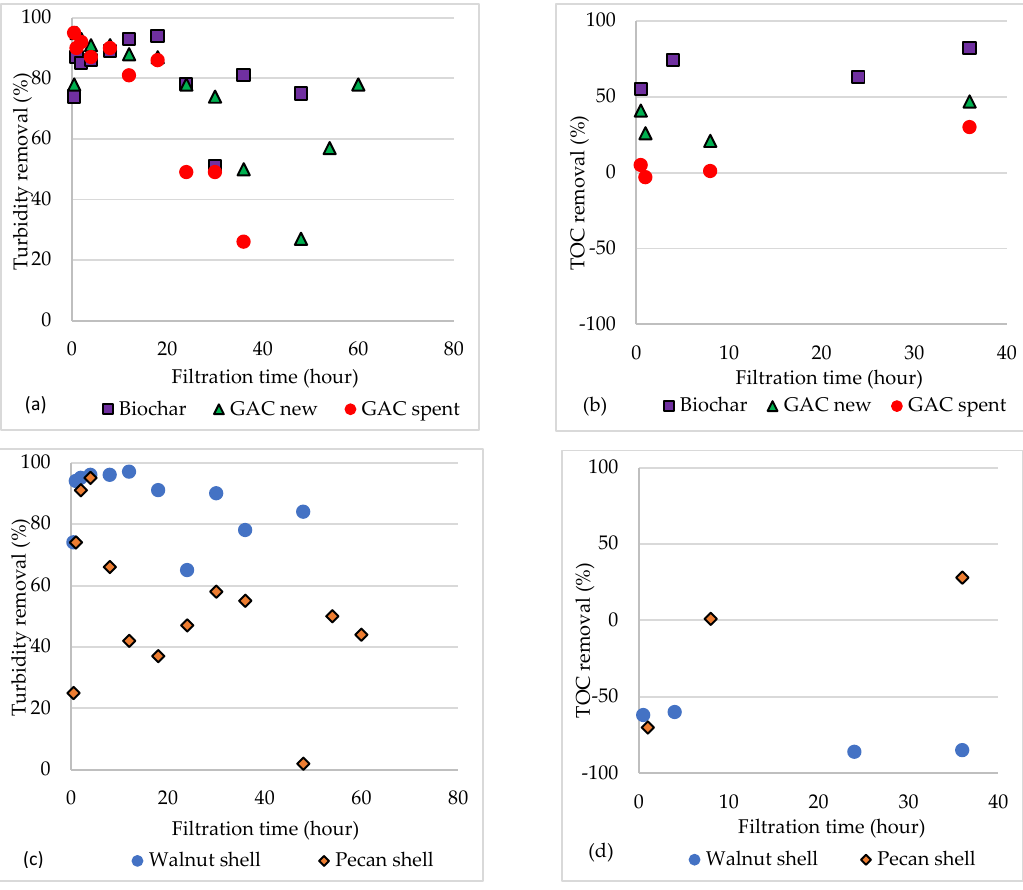
Figure 5. Removal of turbidity ( a ) and ( c ), and removal of TOC ( b ) and ( d ) in different media filters.